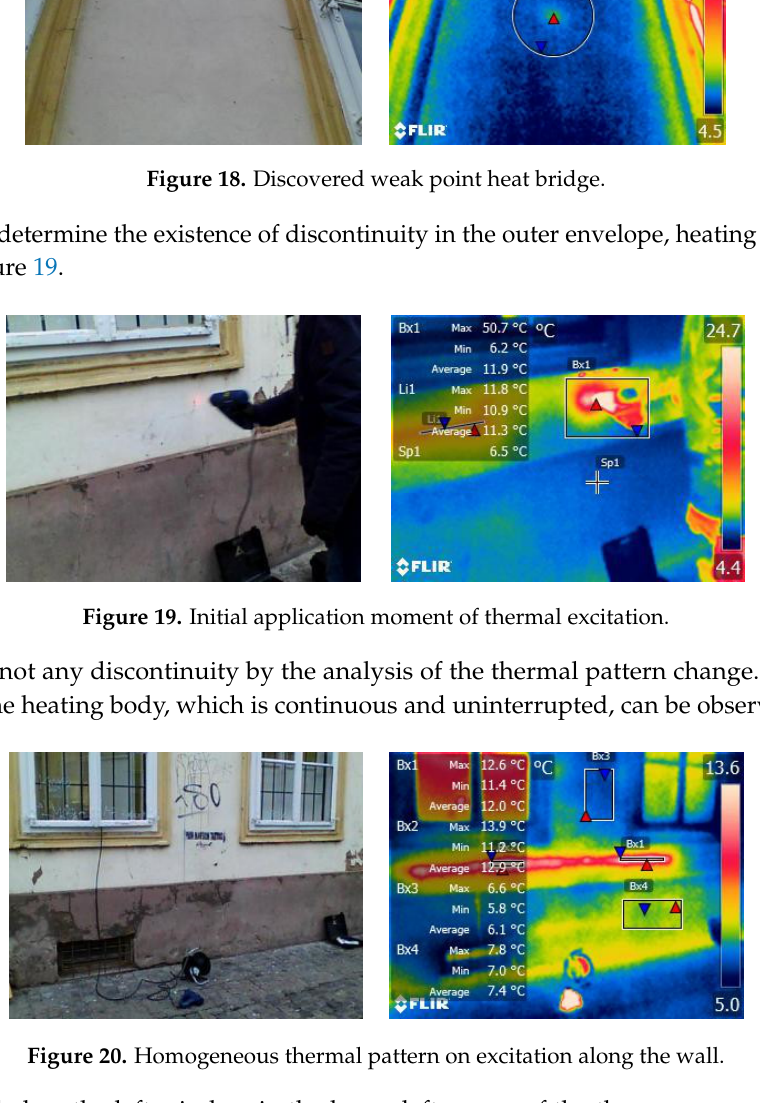
Figure 17. Analysis of facade damage.